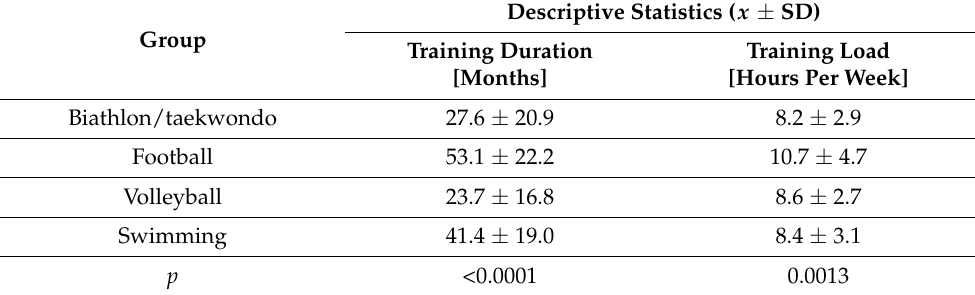
Table 2. Training loads in the studied groups.